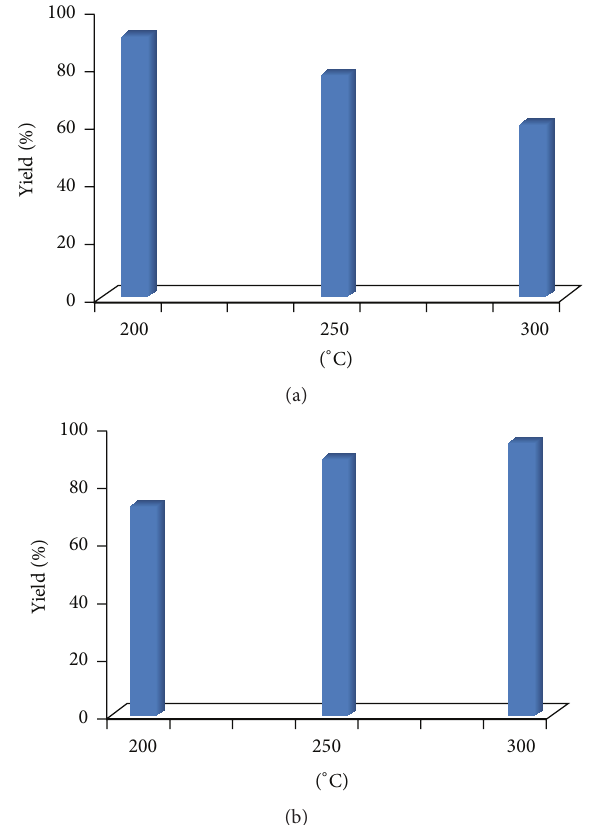
Figure 2: Input and output parameters obtained from sugarcane bagasse torrefaction at various temperatures: (a) mass yield and (b) energy yield.